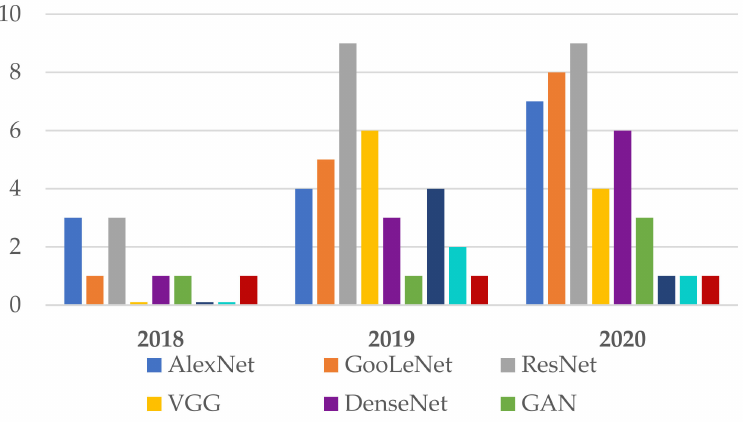
Figure 7. Frequently NNs used in Me detection between 2018 and